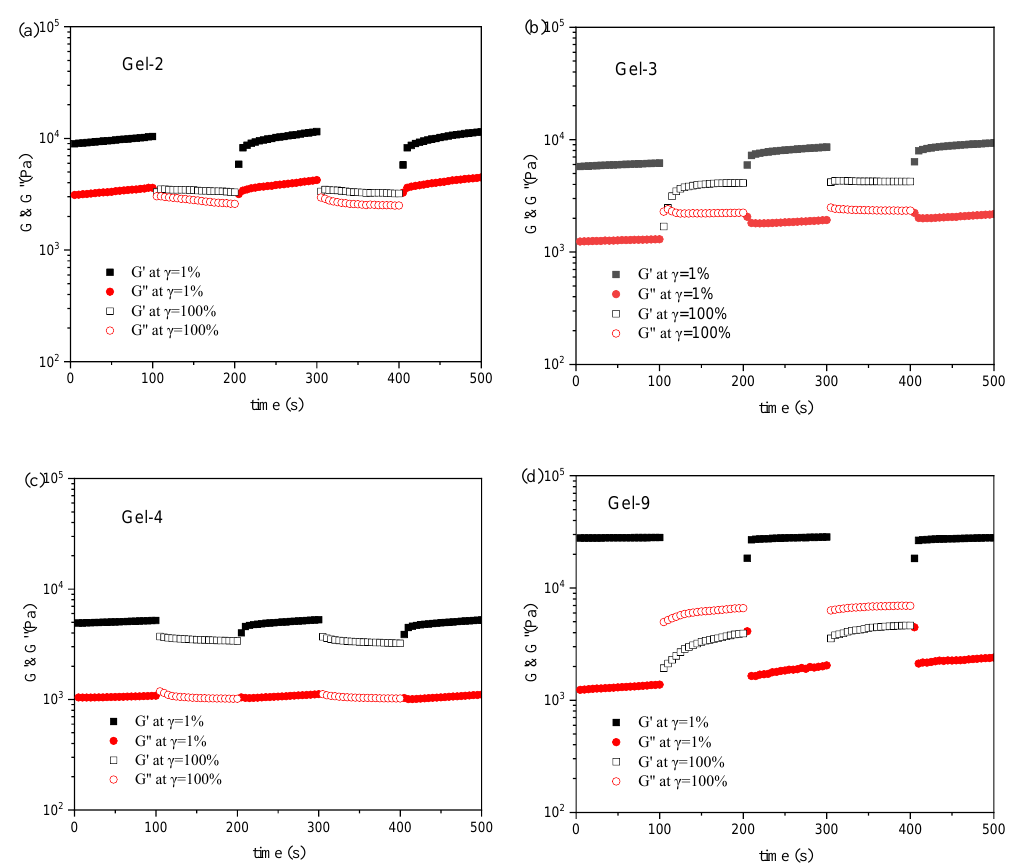
Figure 6. Alternate step strain test with small strain to subsequent large strain with 100 s for every strain interval at fixed angular frequency (10 rad/s) at 37 ℃ : ( a ) Gel-2; ( b ) Gel-3; ( c ) Gel-4; ( d ) Gel-9